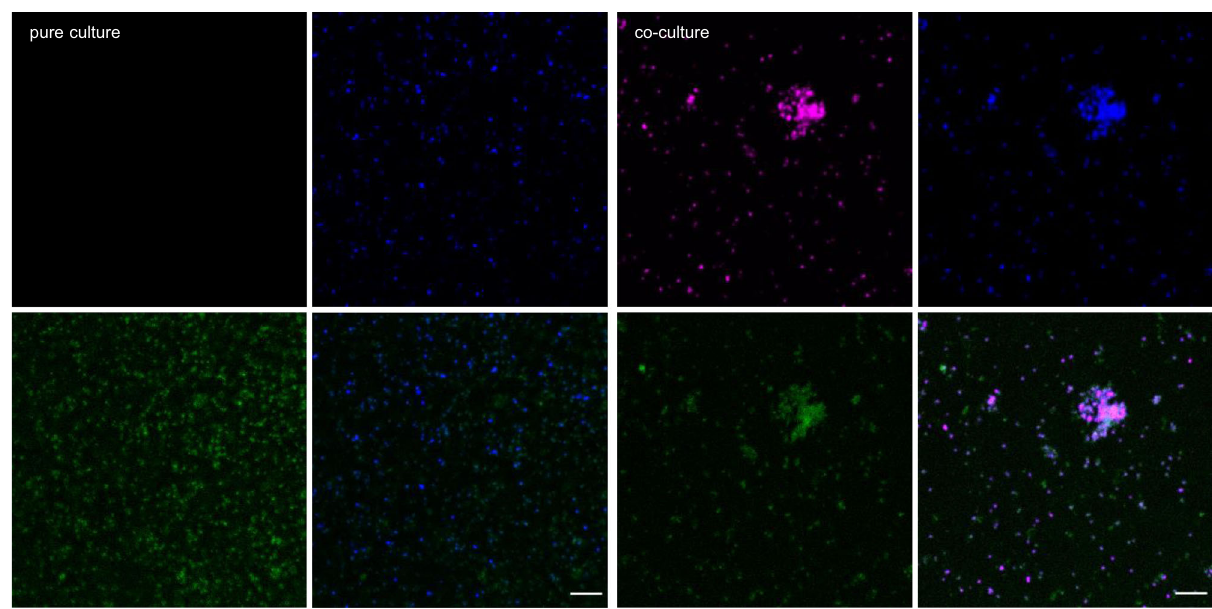
Fig. 3 Results of lectin staining of co-culture of Ca . Micrarchaeum harzensis and Ca . Schef fl eriplasma hospitalis and Ca . Schef fl eriplasma hospitalis pure culture. Shown are example images of the microscopic analysis of the pure culture (left) and co-culture (right). The images show the results for staining with lectin CA (co-culture) and HHA (pure culture). Colour allocation: Ca . Schef fl eriplasma hospitalis was stained with the general archaea probe Arch915 (blue) which does not stain Ca . Micrarchaeum harzensis. Ca . Micrarchaeum harzensis was stained using the Micrarchaeota-speci fi c ARMAN980 probe (magenta). Lectin staining is shown in green. Scale bars represent 10 µ m. The experiment was repeated at least three times with equivalent